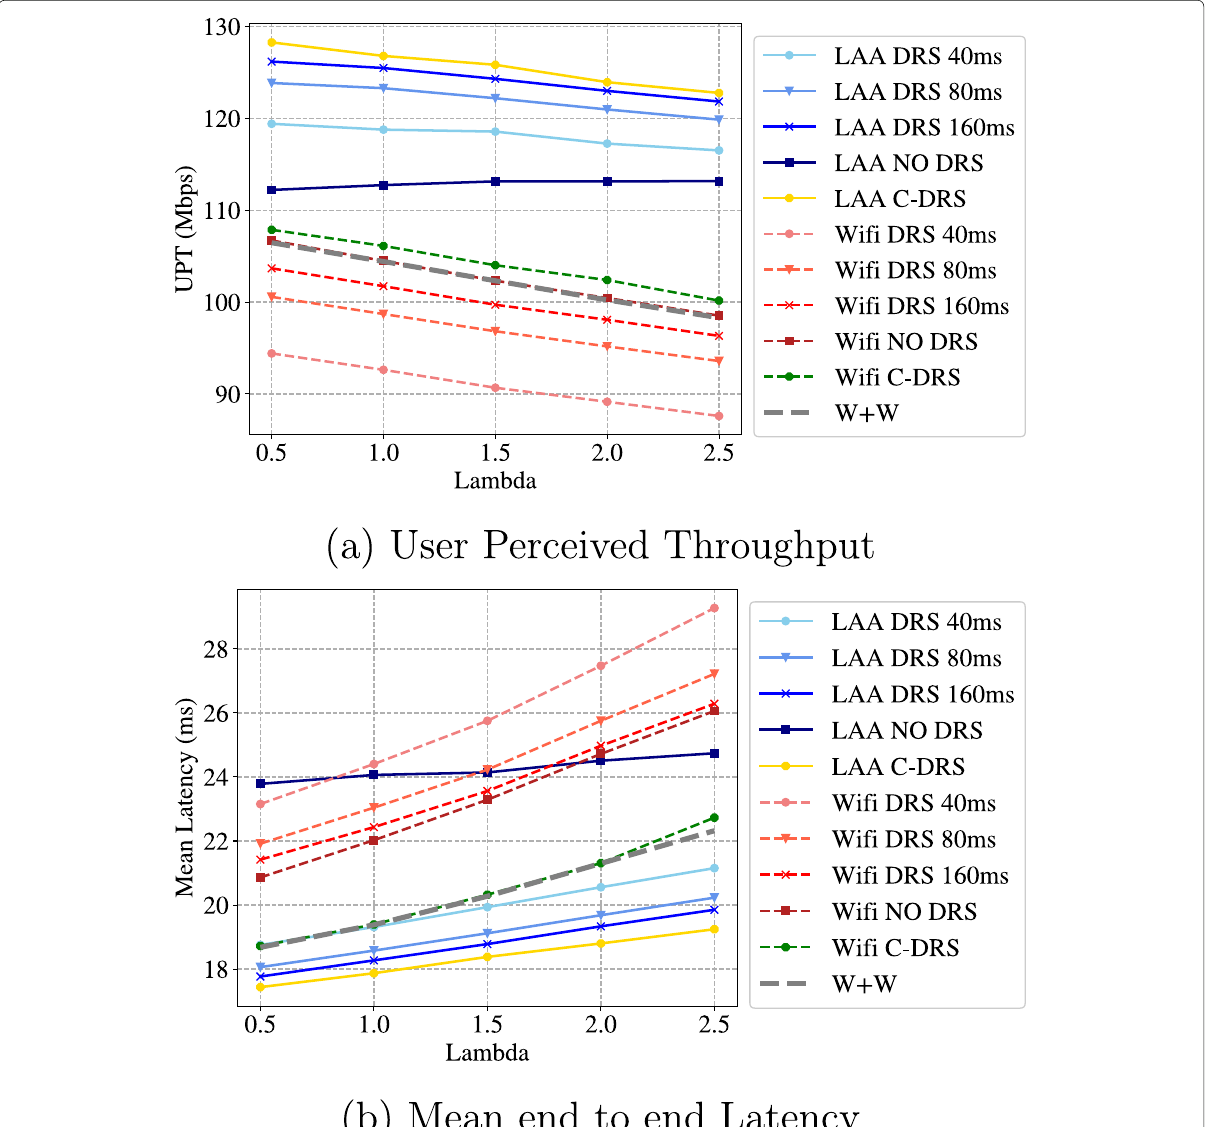
Fig. 2 Performance comparison of the different signaling